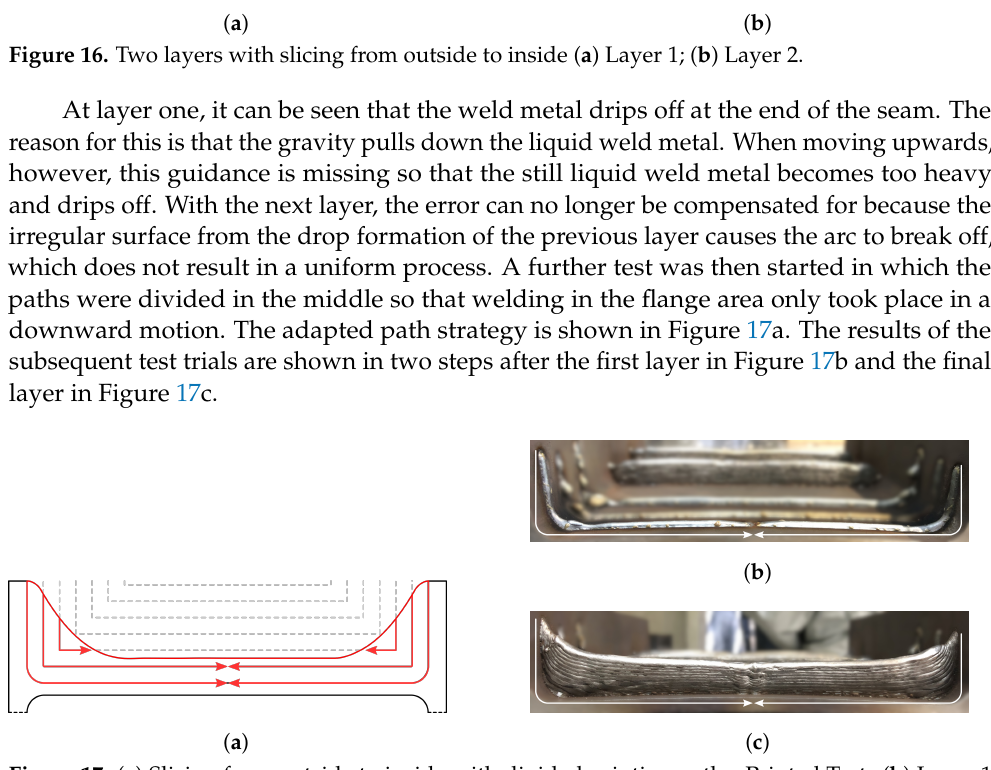
Figure 17. ( a ) Slicing from outside to inside with divided printing paths; Printed Tests ( b ) Layer 1 and ( c ) Layer